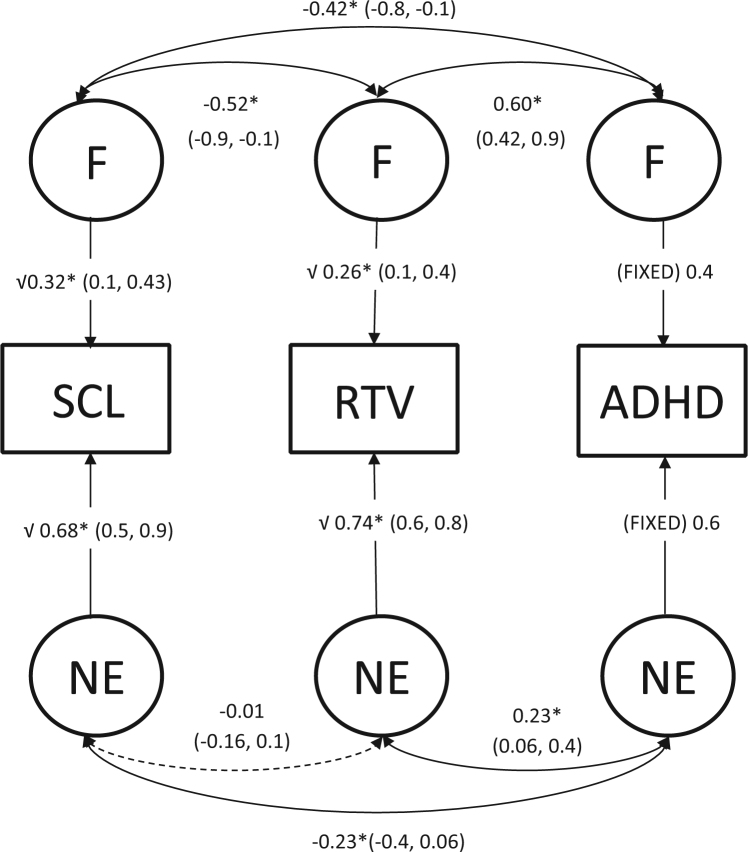
Standardized solution of the full correlated factor model across skin conductance level (SCL), reaction time variability (RTV), and attention-deficit/hyperactivity disorder (ADHD) in the baseline condition. Solid lines and asterisks depict significant paths (p ≤ .05) and dotted lines depict nonsignificant paths (p > .05). Confidence intervals are indicated in parentheses. F, familial effects; NE, nonshared effects.